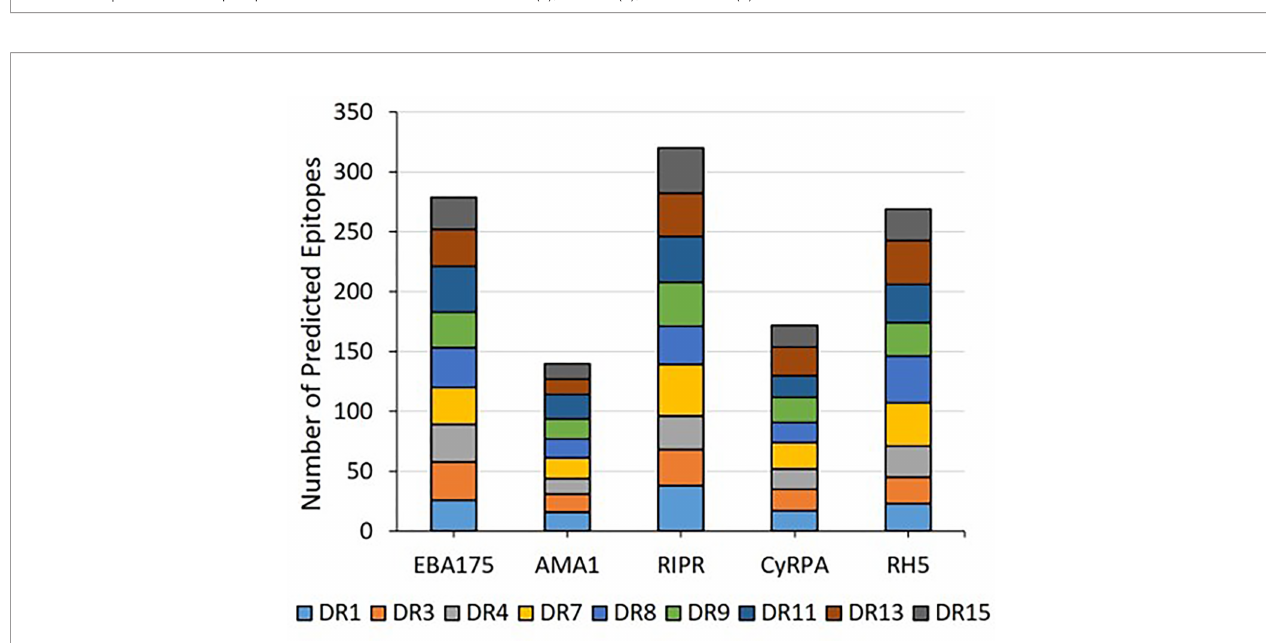
FIGURE 1 | The three-step experimental work fl ow includes in silico (1), in vitro (2), and ex vivo (3)